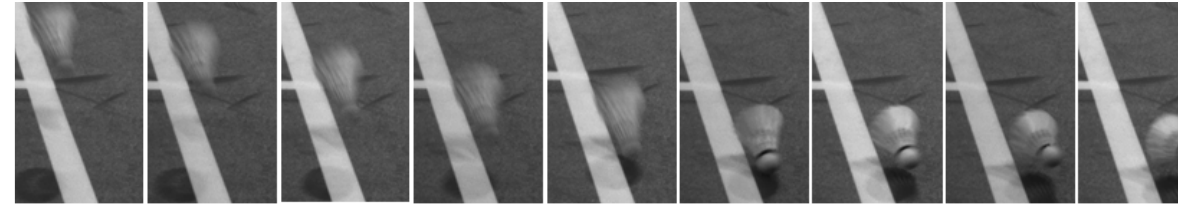
Figure 16. Example shuttlecock trajectory before and after ground hit.